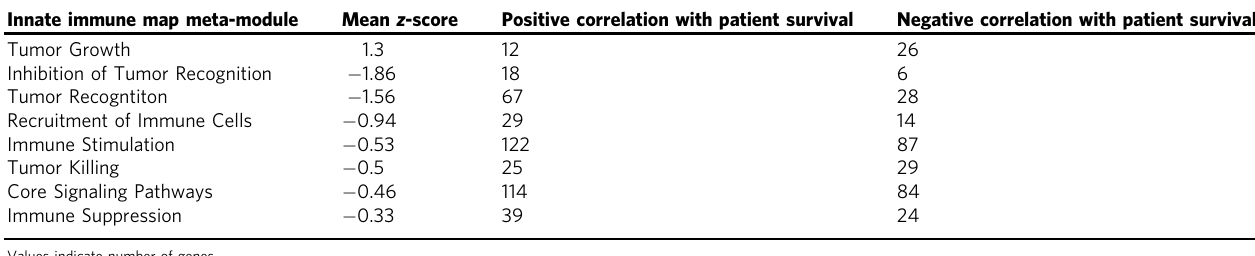
Table 2 Distribution of genes with positive ( z < 0) and negative ( z > 0) correlation with patient survival across functional meta- modules in innate immune response